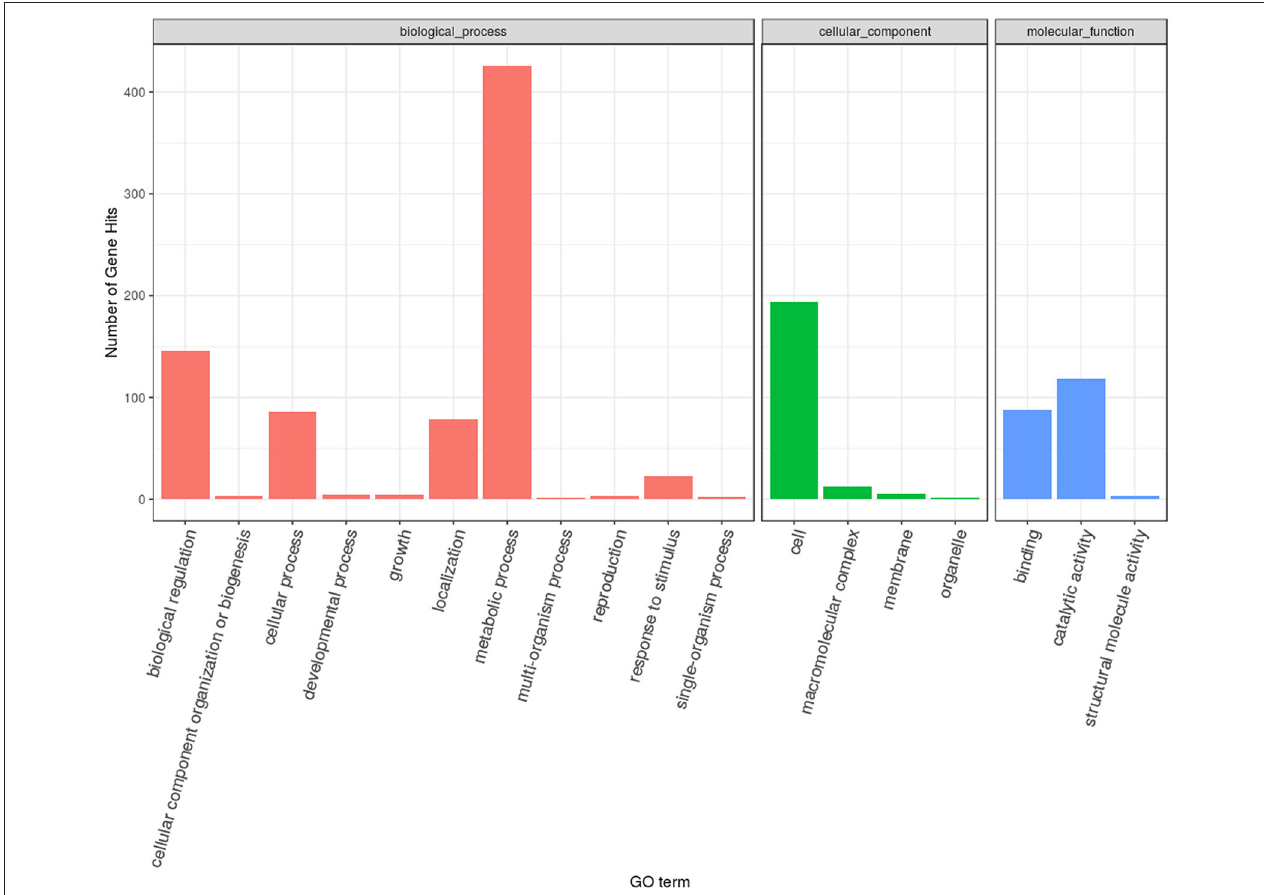
FIGURE 1 | The gene ontology annotation of differential expression genes.